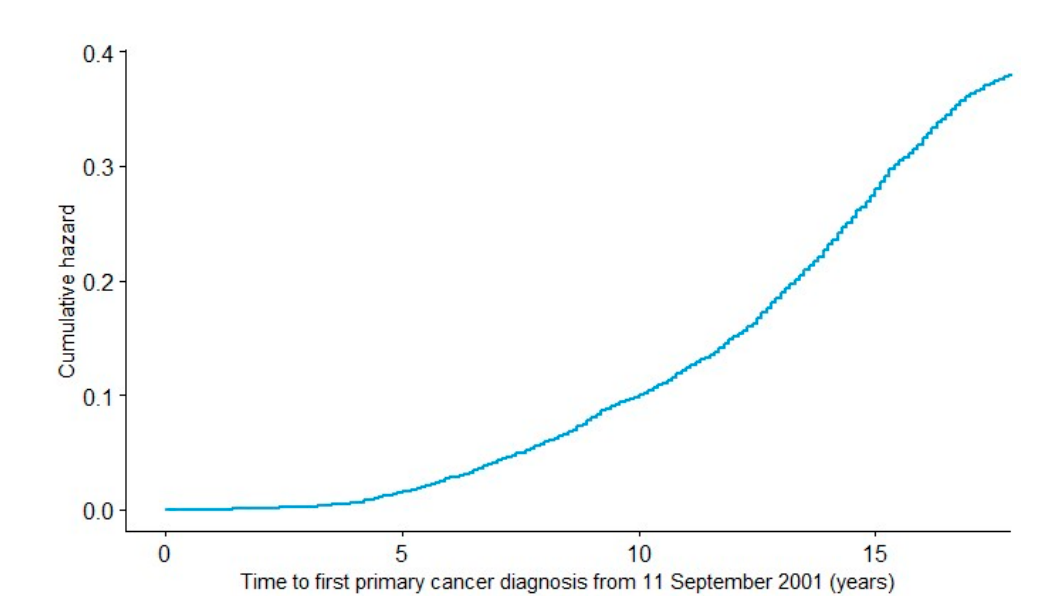
Figure 2. Cumulative hazards for first primary cancer diagnosis from 11 September 2001 among cancer patients in WTC EHC pan-cancer database.